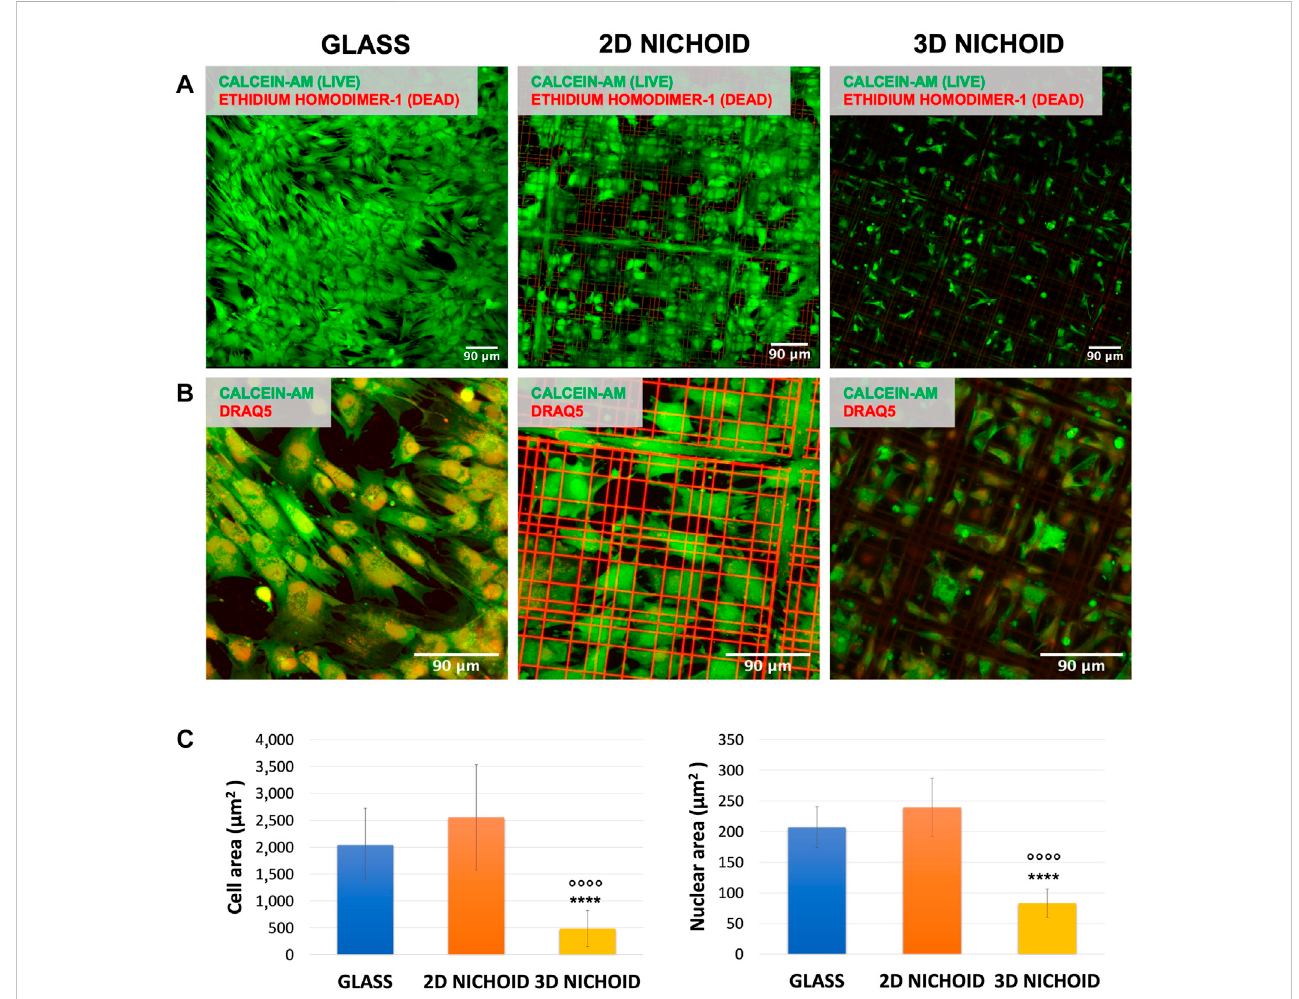
FIGURE 1 (A) Fluorescence images of live (green) and dead (red) rBMSCs cultured on glass coverslips and 2D and 3D Nichoids at day 4. Scale bar = 90 μ m. (B) Fluorescenceimagesofthecytoplasm(green)andnuclei(red)ofrBMSCsculturedonglasscoverslipsand2Dand3DNichoidsatday4.Scalebar=90 μ m. (C) Quanti fi cationofthecellularandnuclearareainthethreeconditions.****indicates p value ≤ .0001forthe3Dvs.2DNichoidcomparison,and oooo indicates p value ≤ .0001 for the 3D vs. glass